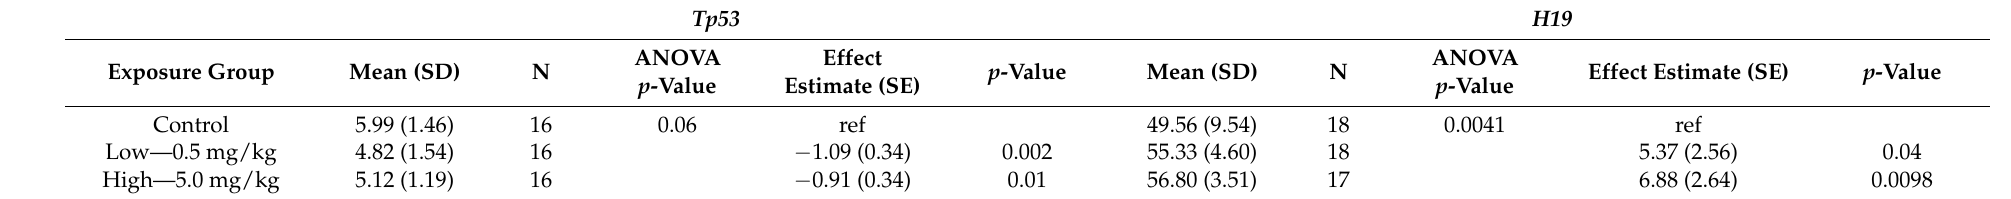
Table 3. DNA Methylation by Aflatoxin B1 Exposure Group at 3 Weeks of Age in Liver. Tp53 H19